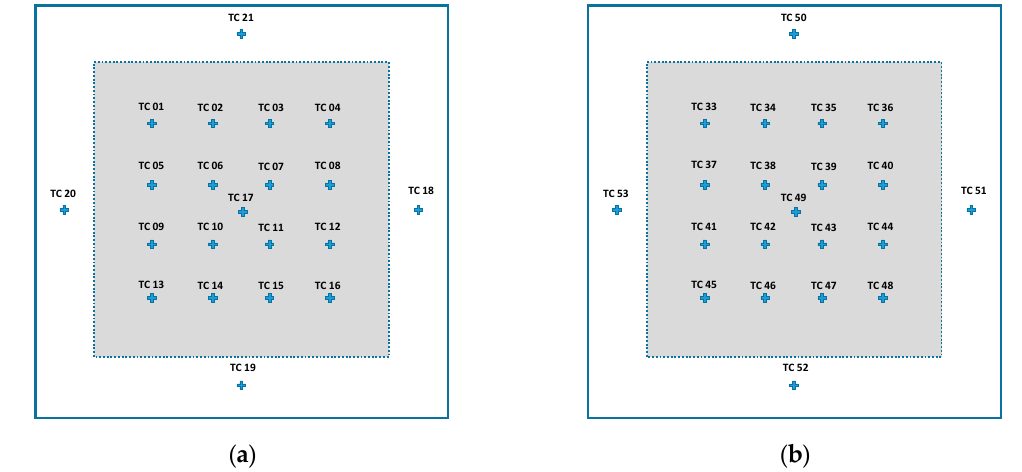
Figure 2. Metered area of the test specimen: ( a ) warm side (ID); ( b ) cold side (OD).